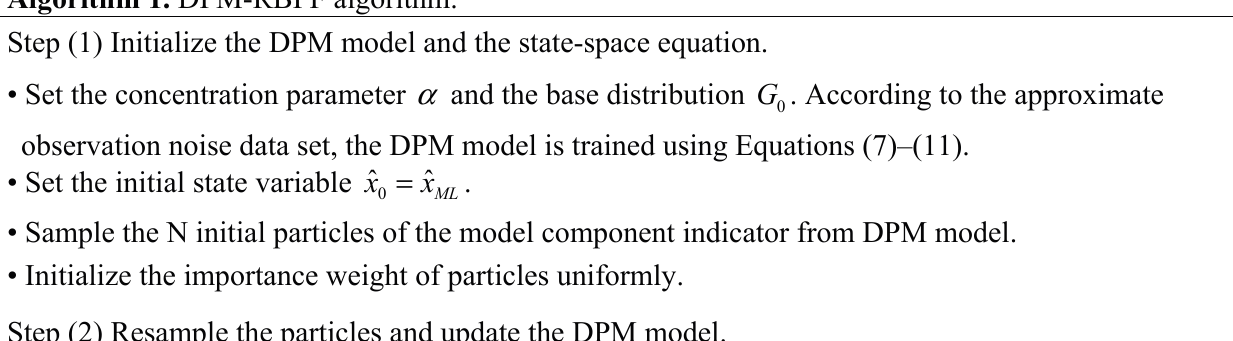
Algorithm 1. DPM-RBPF